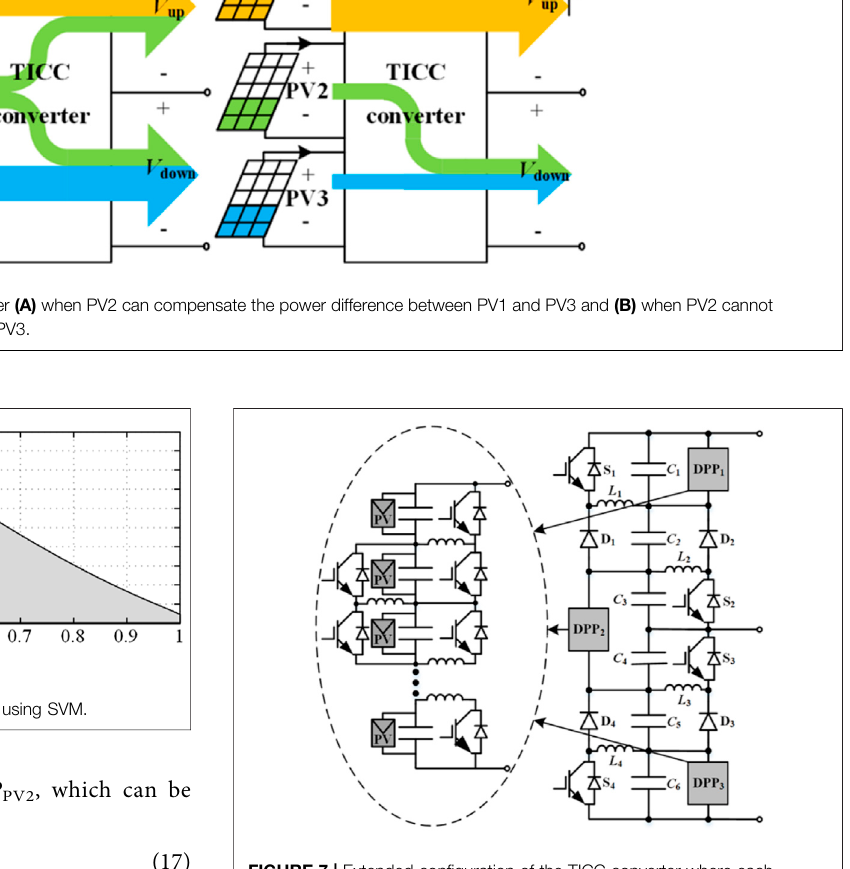
FIGURE 7 | Extended con fi guration of the TICC converter where each PV source is replaced with the DPP